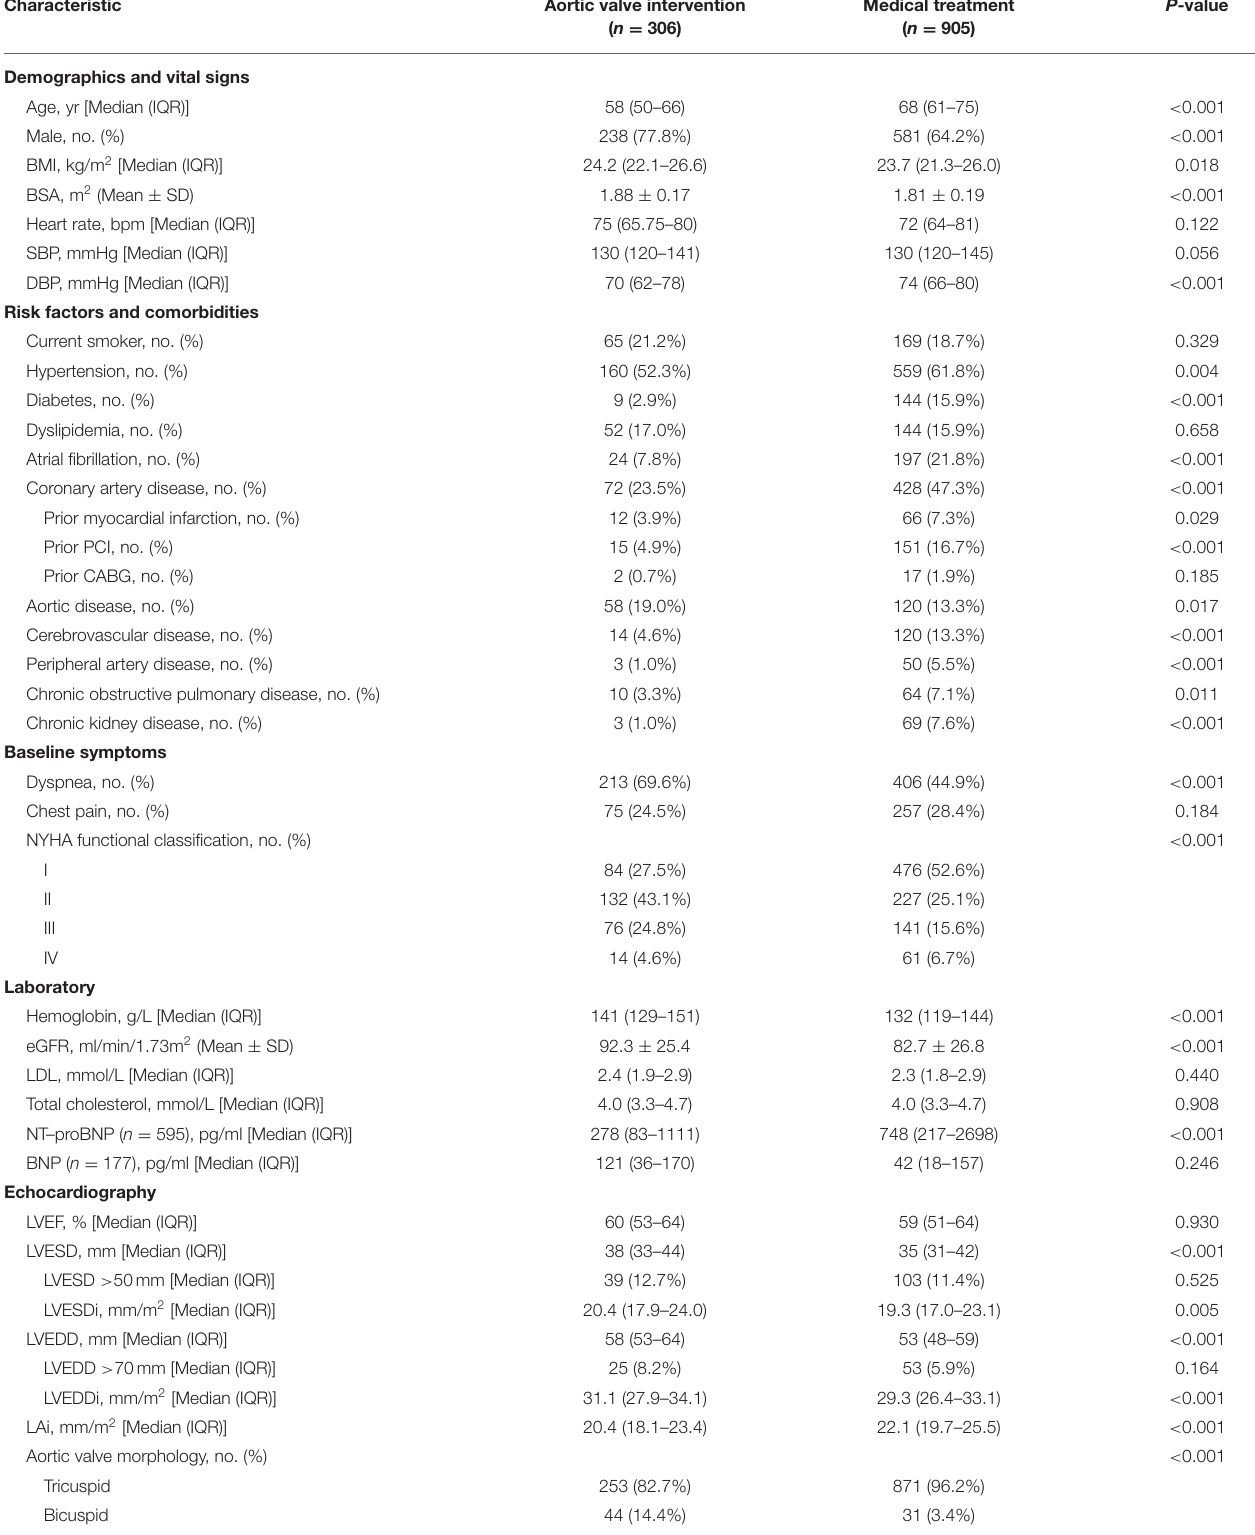
TABLE 2 | Baseline characteristics according to treatment